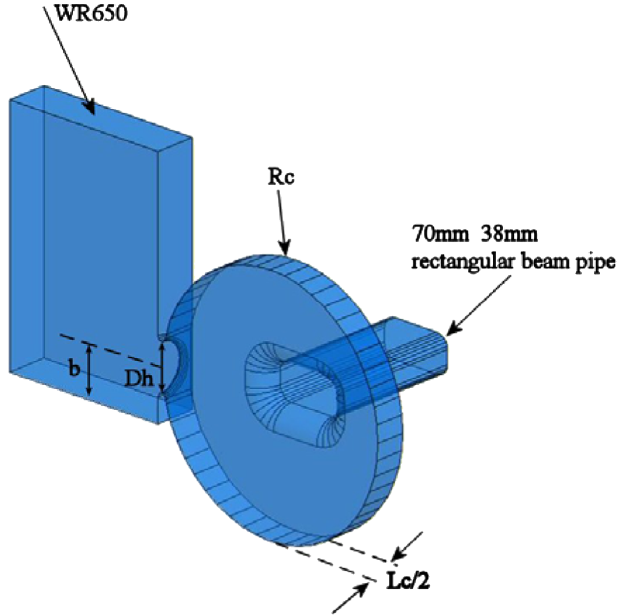
FIG. 6. (Color) Single cell cavity geometry.